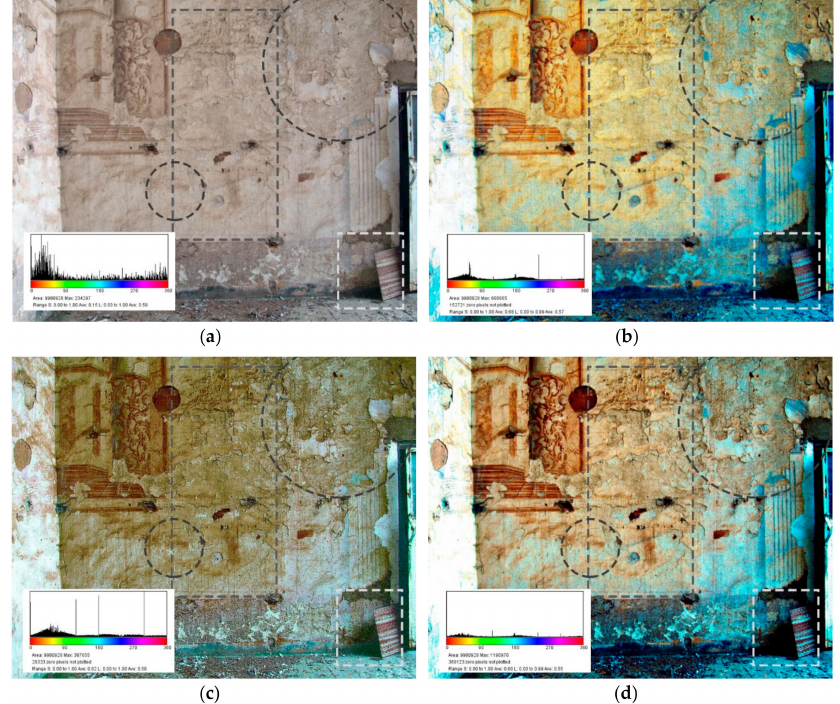
Figure 10. Analysis of right-hand panel (RW): ( a ) Initial RGB image; ( b ) LDS filter highlighting bluish motifs and the finishing on the lower section of the pilasters flanking the entrance; ( c ) YYE filter revealing the square and centrally positioned decoration that is invisible to the naked eye; ( d ) general enhancement of all elements using a LAB